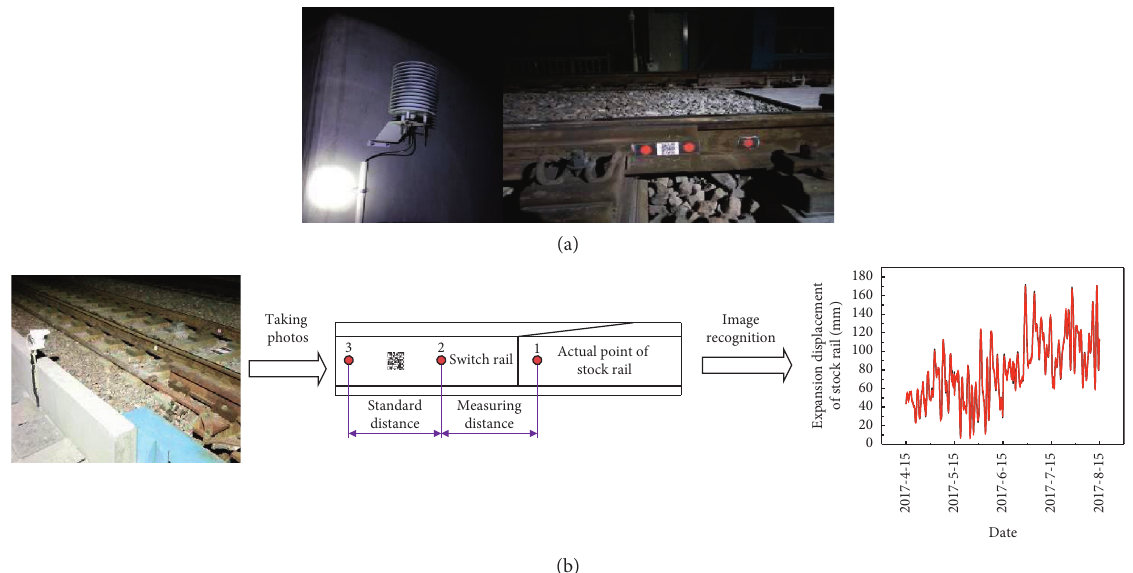
Figure 14: Measurement of Image Intelligent Identification technology. (a) Measurement point for the atmospheric temperature and displacement of the switch rail. (b) Monitoring method of the expansion displacement of